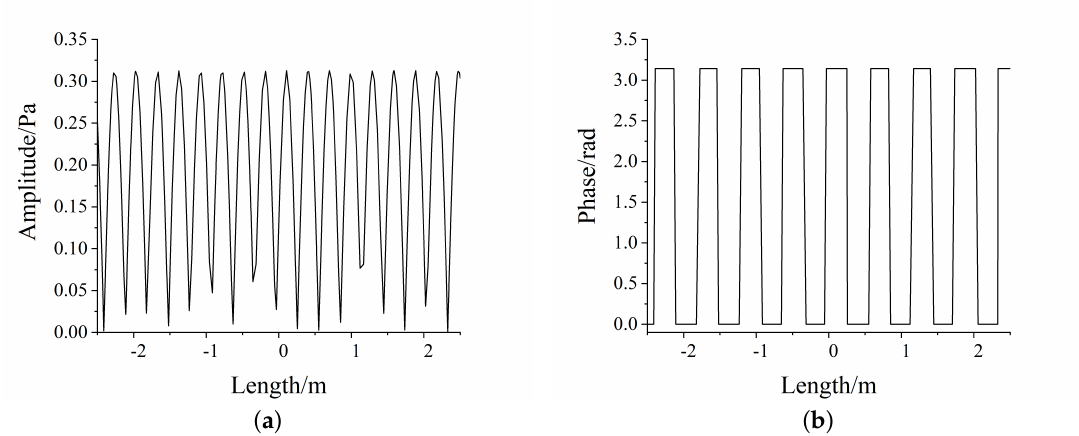
Figure 6. ( a )The information of sound pressure amplitude in impedance tube downstream without sample at 2500 Hz. ( b ) The information of sound pressure phase in impedance tube downstream without sample at 2500